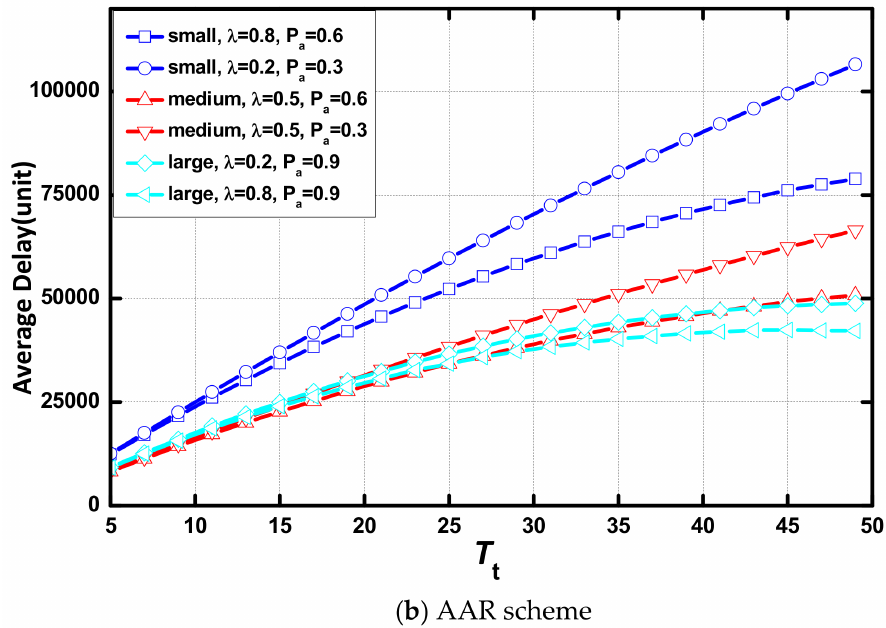
Figure 7. Average delay vs. T t in different scenarios.